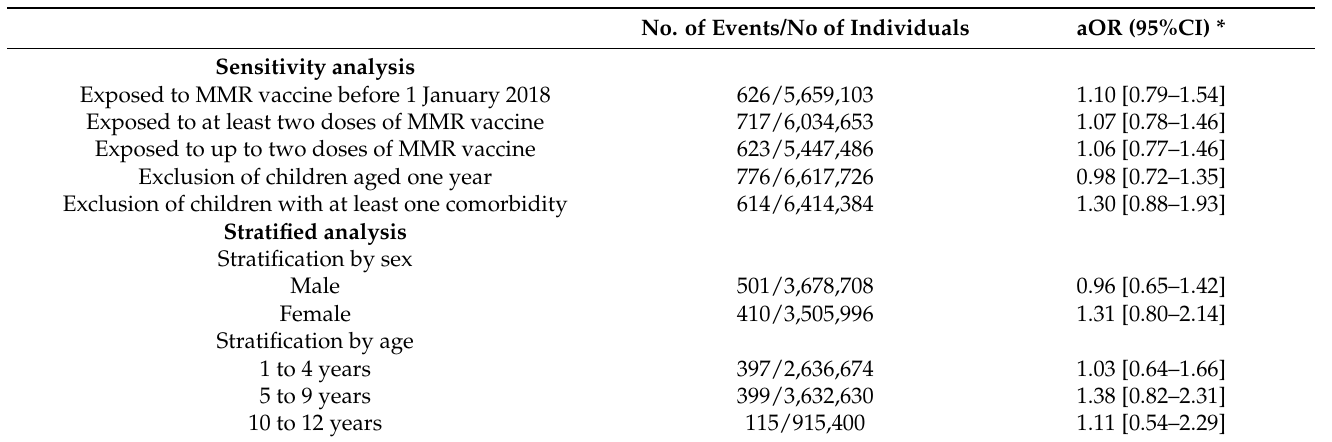
Table 3. Sensitivity and stratified analysis of the association between exposure to MMR vaccine and the risk of hospitalization for COVID-19 in a multi-variate logistic regression model weighting for the inverse probability of